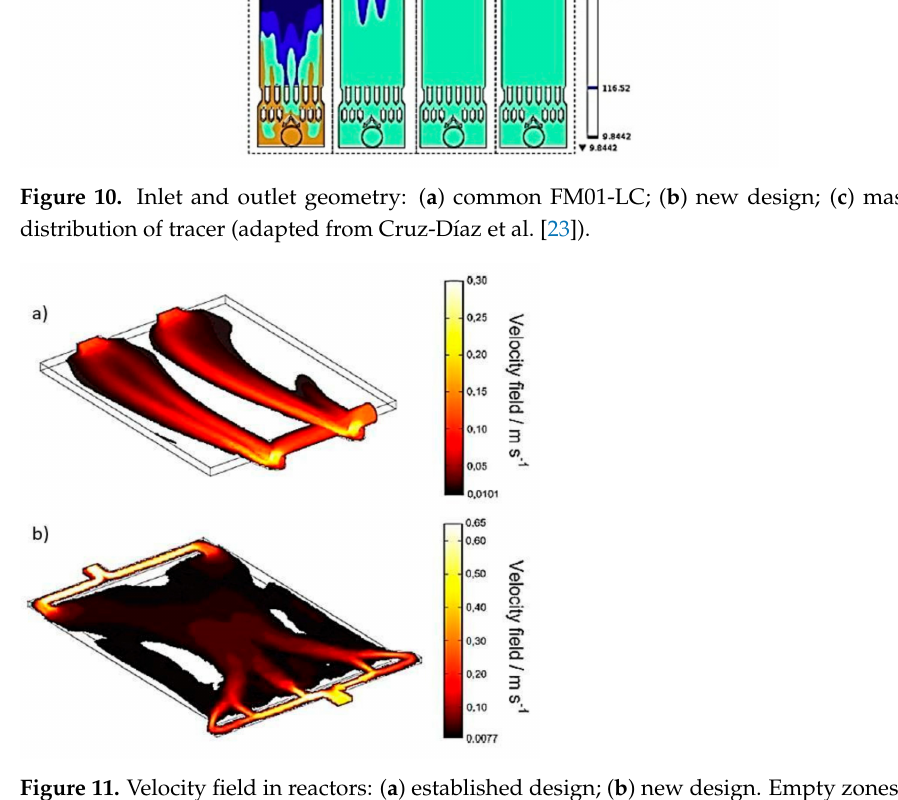
Figure 11. Velocity field in reactors: ( a ) established design; ( b ) new design. Empty zones designate stagnant zones